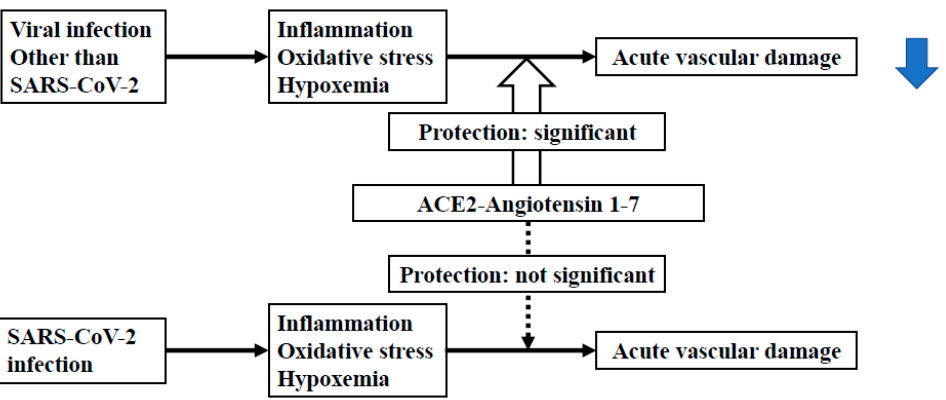
Figure 1. Comparison of the effects of severe acute respiratory syndrome coronavirus 2 (SARS-CoV-2) infection and other infections on acute vascular dysfunction via angiotensin converting enzyme 2 (ACE2)-Angiotensin 1-7.